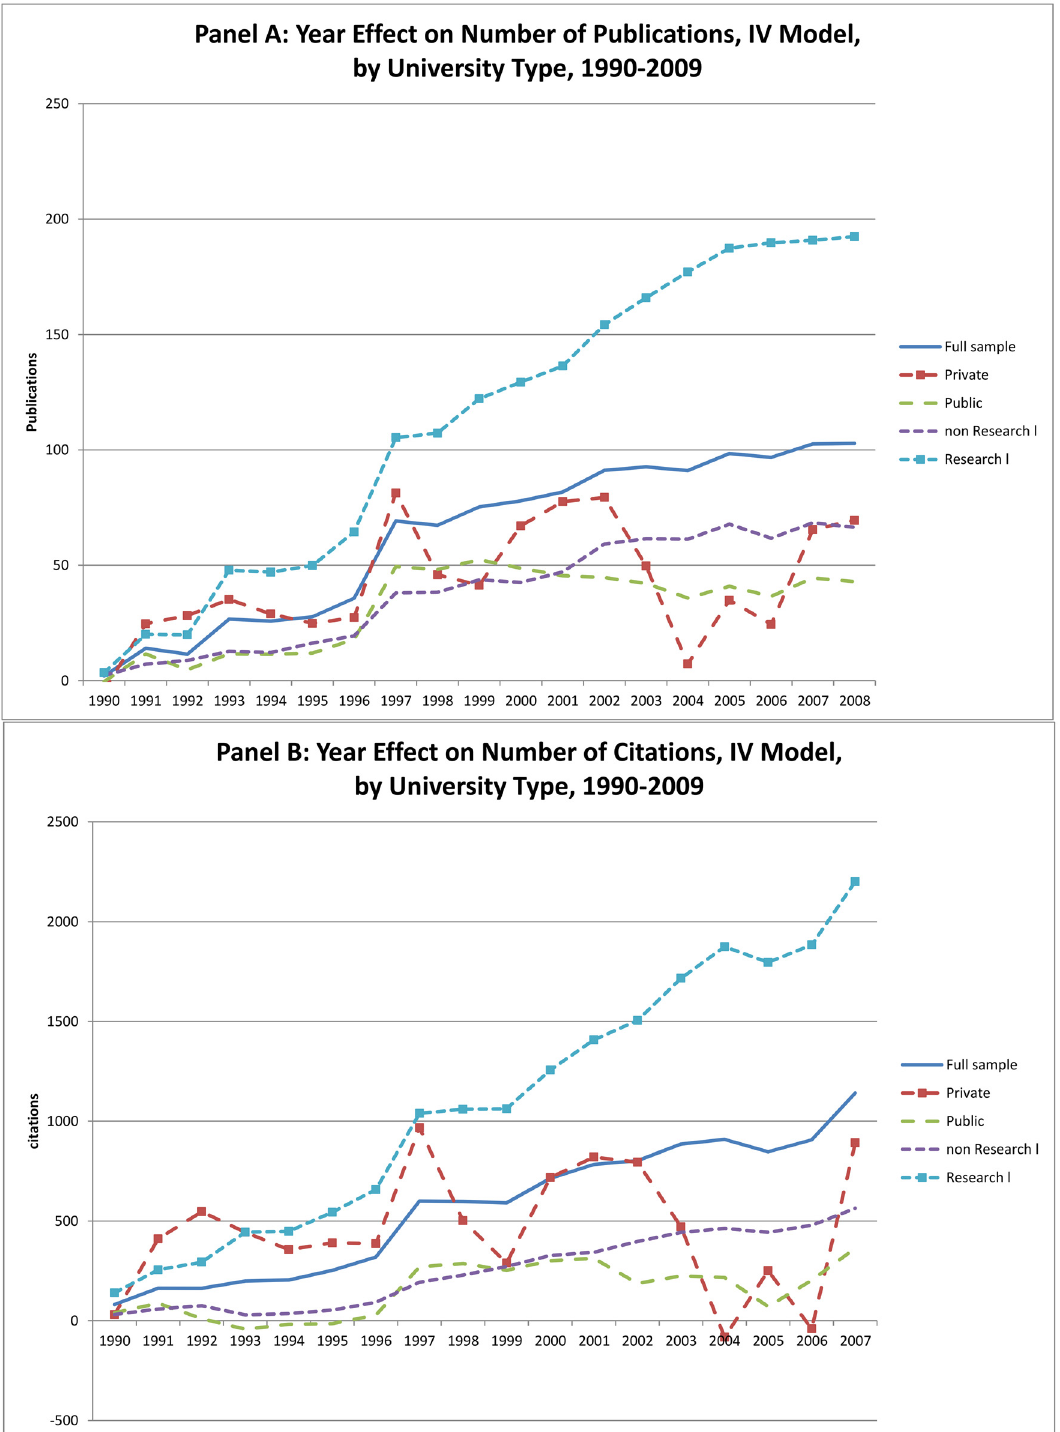
Fig 7. Year Effects from IV Regressions on Number of Publications and Citations.